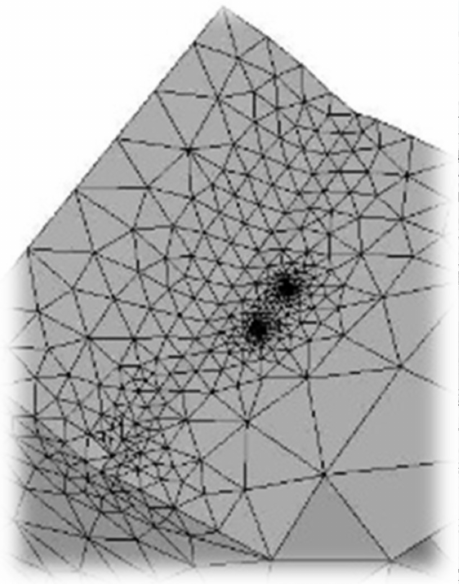
Figure 5. Inserted semielliptical surface crack at the weld toe